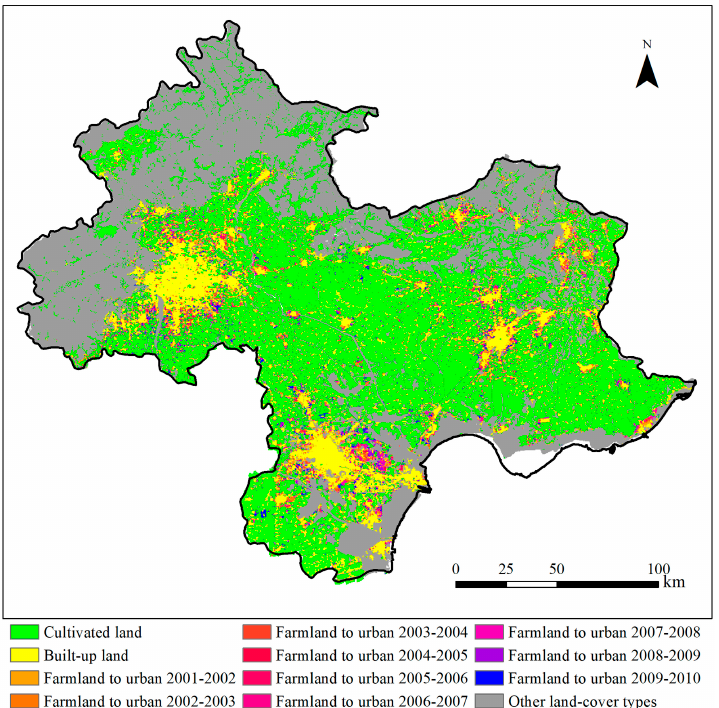
Figure 16. Long-term mapping of urban expansion patterns of the entire study area from 2001 to 2010. The main urban districts in ( a ) Beijing, ( b ) Tianjin, and ( c ) Tangshan.